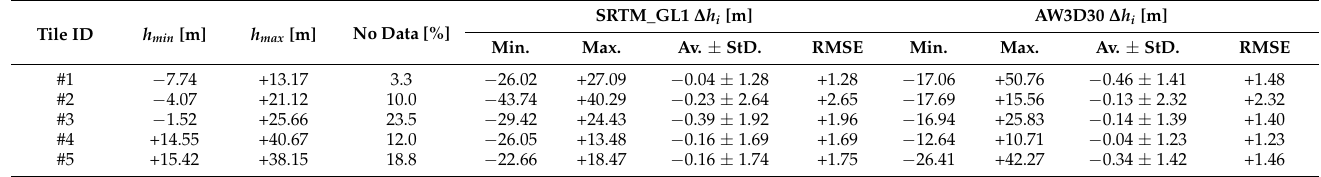
Table 2. Main characteristics of the five COSMO-SkyMed SM DEM products and accuracy statistics from their comparison with the SRTM_GL1 and AW3D30 DEMs at 30 m resolution. Notation: h min and h max : minimum and maximum elevation above reference ellipsoid; Min.: minimum; Max.: maximum; Av.: average; StD.: standard deviation; RMSE: root mean square